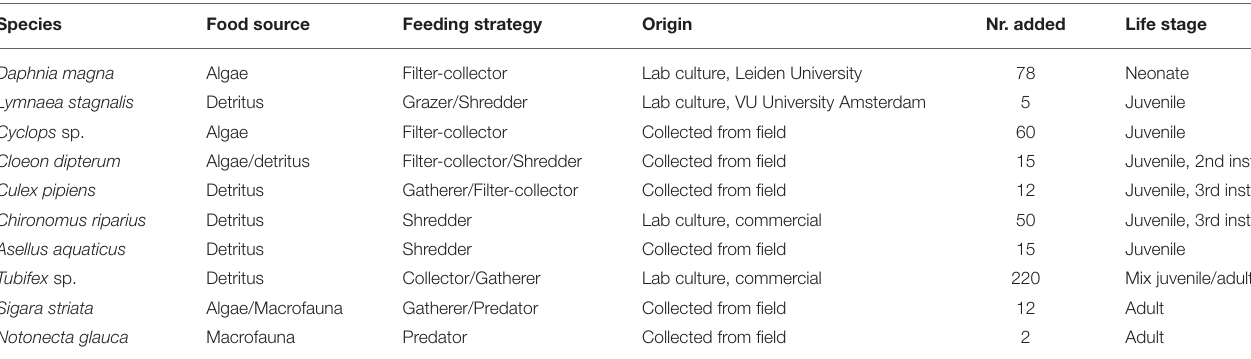
TABLE 1 | Characteristics of species and numbers used in the mesocosm experiment. Species Food source